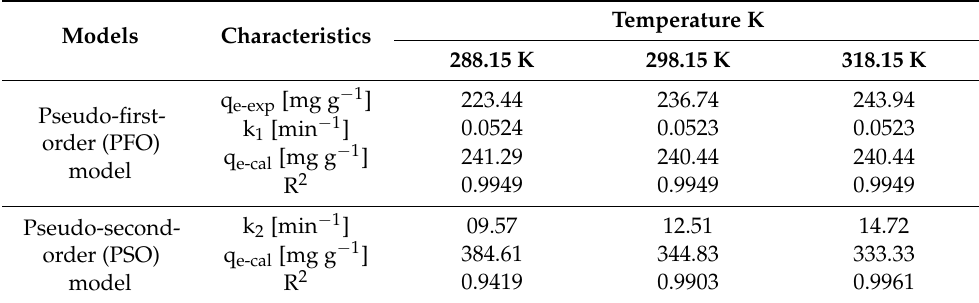
Figure 7. Adsorption kinetics of Az on Ni/Zn LDH nanohybrid: ( a ) pseudo-first-order, ( b ) pseudo-second-order (PSO) kinetics model. Table 2. Coefficients of pseudo-first-order (PFO) and pseudo-second-order (PSO) adsorption kinetic models.